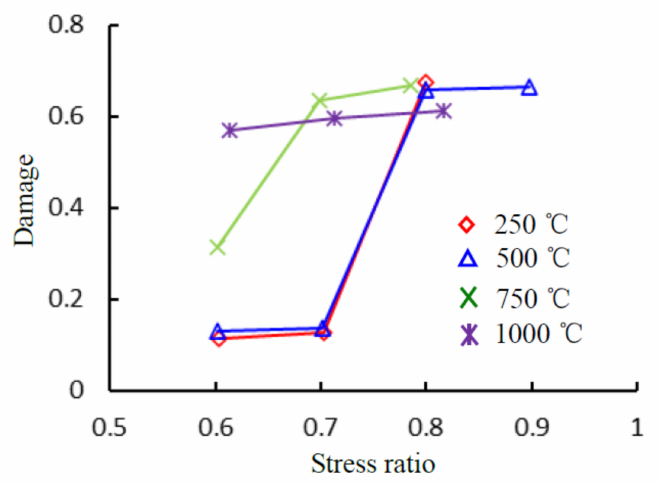
Figure 14. Ultimate failure modes of pre-cracked sandstone specimen after creep compression.